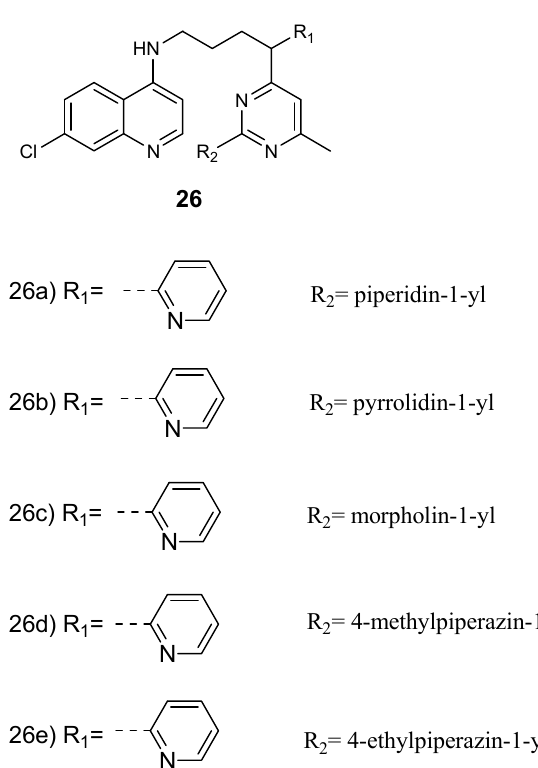
Figure 10. Structure of 4-aminoquinoline-pyrimidine hybrid compounds.